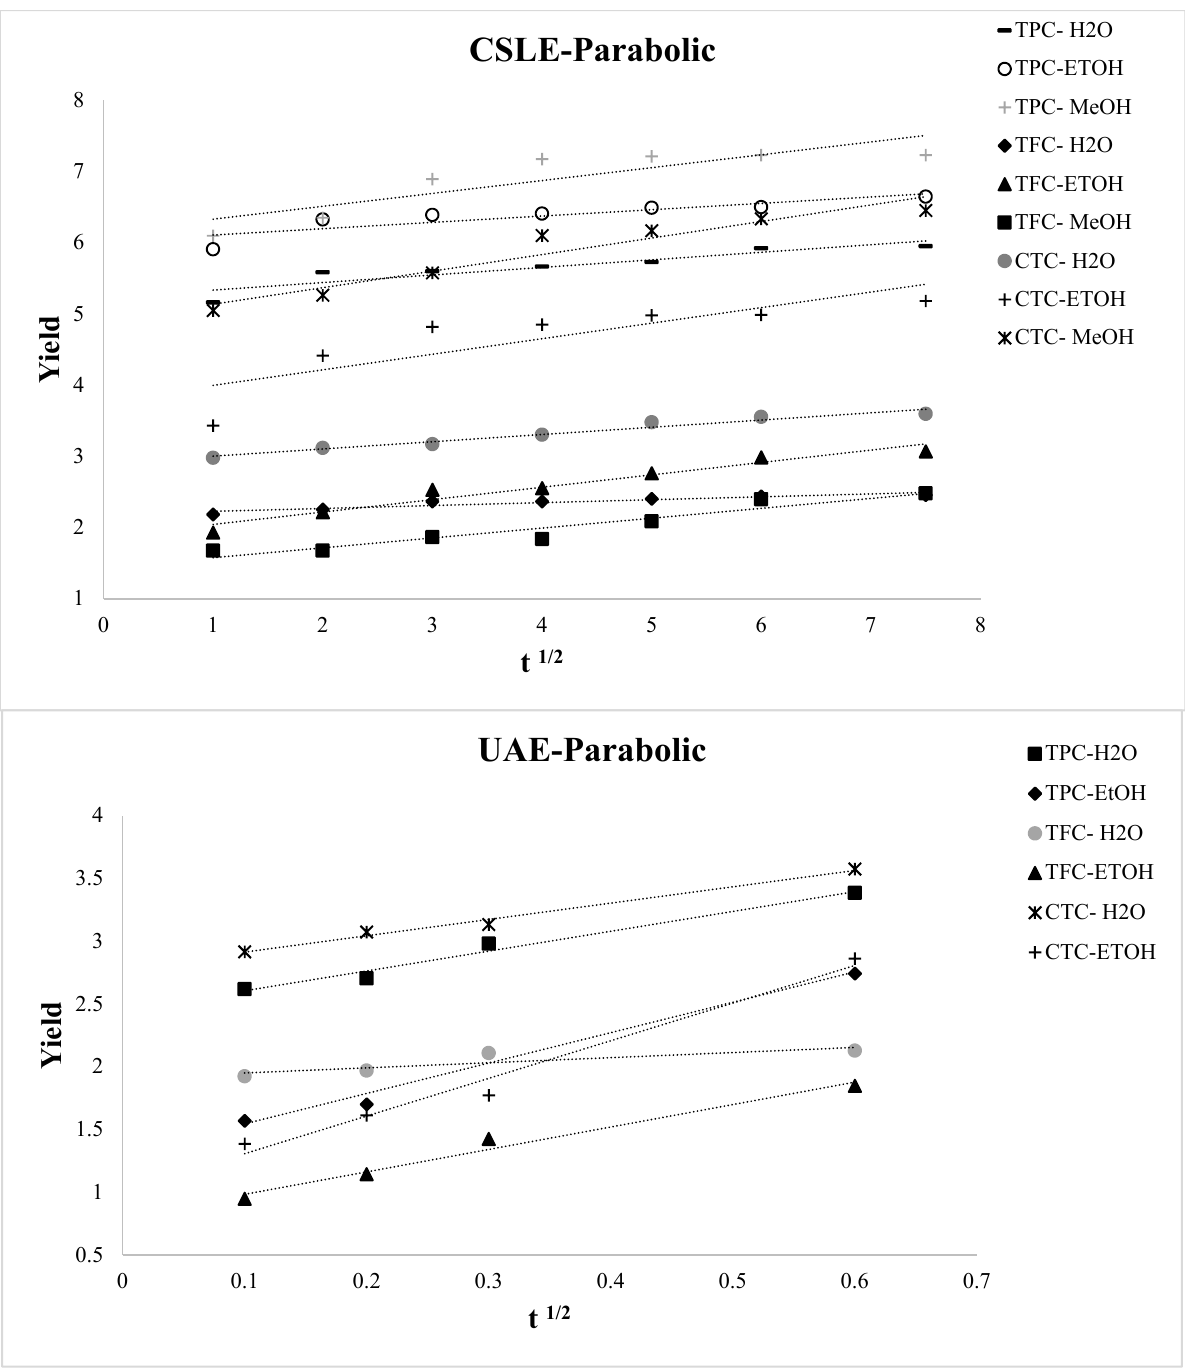
Figure 6. Plot of parabolic model for conventional solid-liquid extraction (CSLE) and ultrasound-assisted extraction (UAE) for the total phenolic compound (TPC), total flavonoid compound (TFC), and total condensed tannin compound (CTC) using the different selected solvents.